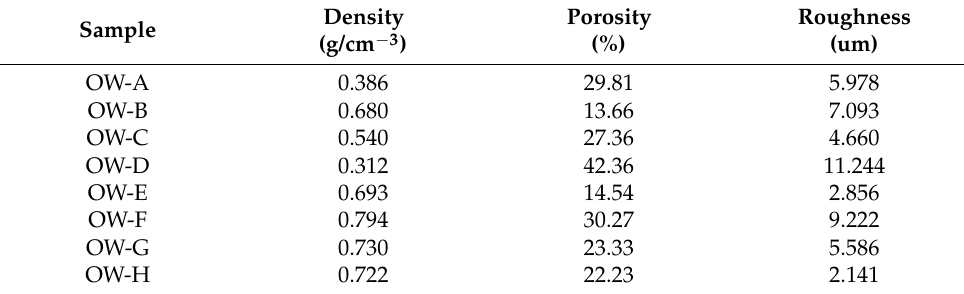
Figure 3. The relationship between original roughness and hydrophobicity and the roughness ratio of wood before and after modification. Table 2. Original wood density, porosity, and